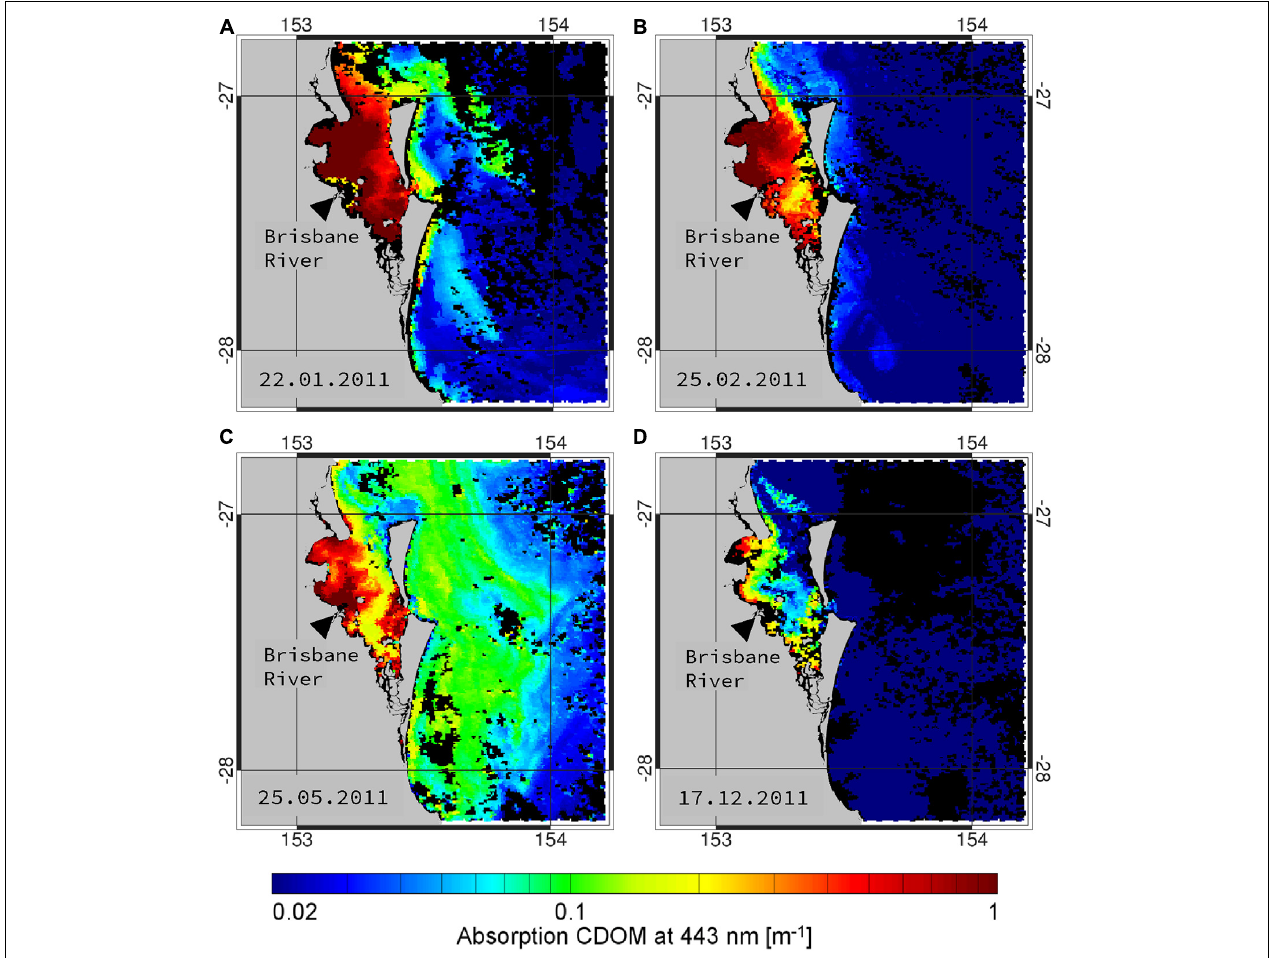
FIGURE 2 | Sequence of remotely sensed images of CDOM absorption at 443 nm from MODIS observations covering Moreton Bay on 22 January, 25 February, 25 May, and 17 December